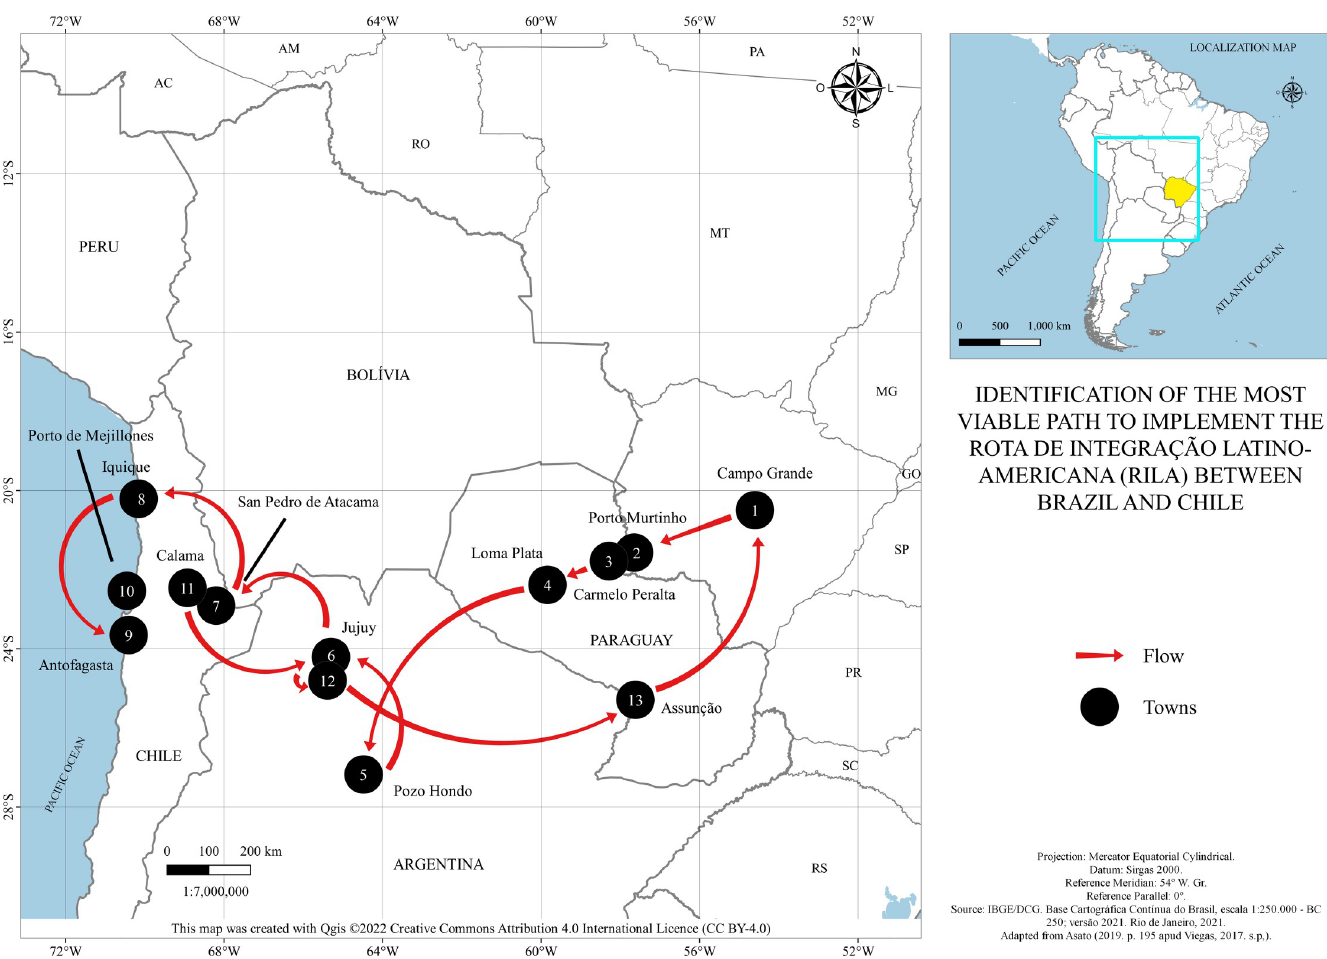
Fig 1. The identification of the most viable path for implementing the Rota de Integração Latino-Americana (RILA) between Brazil and Chile. Caption credit: Own development based on data from [9]. Adapted from